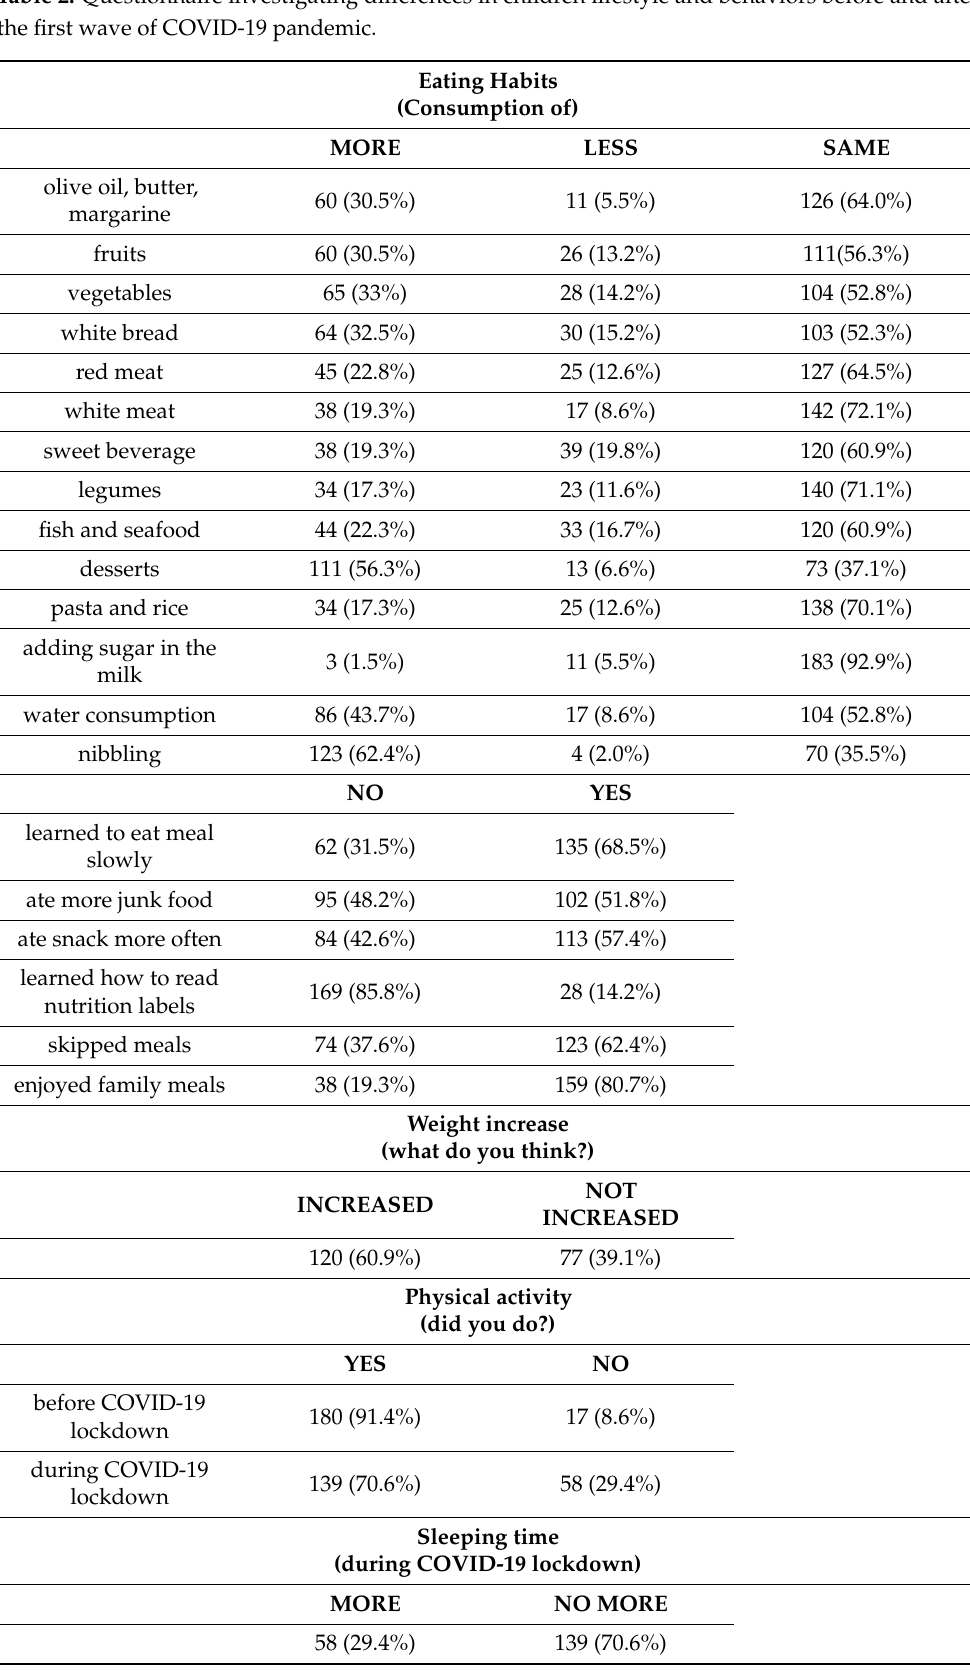
Table 2. Questionnaire investigating differences in children lifestyle and behaviors before and after the first wave of COVID-19